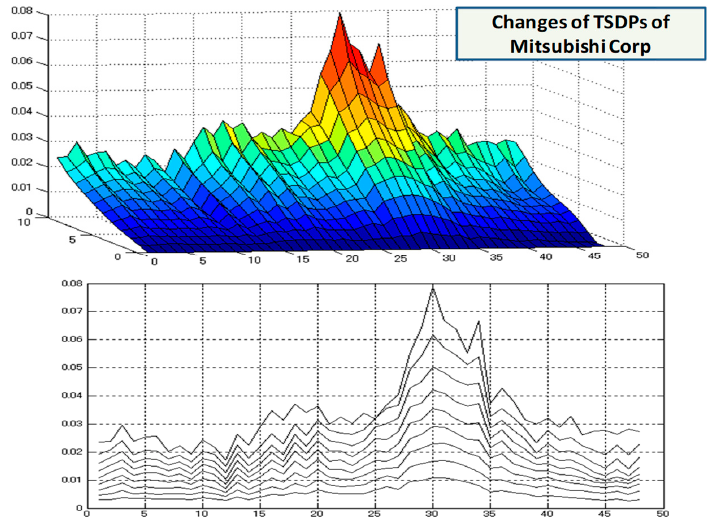
Figure 15. Time series movements of TSDPs of Mitsubishi Corp. for September 2006 through August 2010. The 30th month corresponds to February 2009.